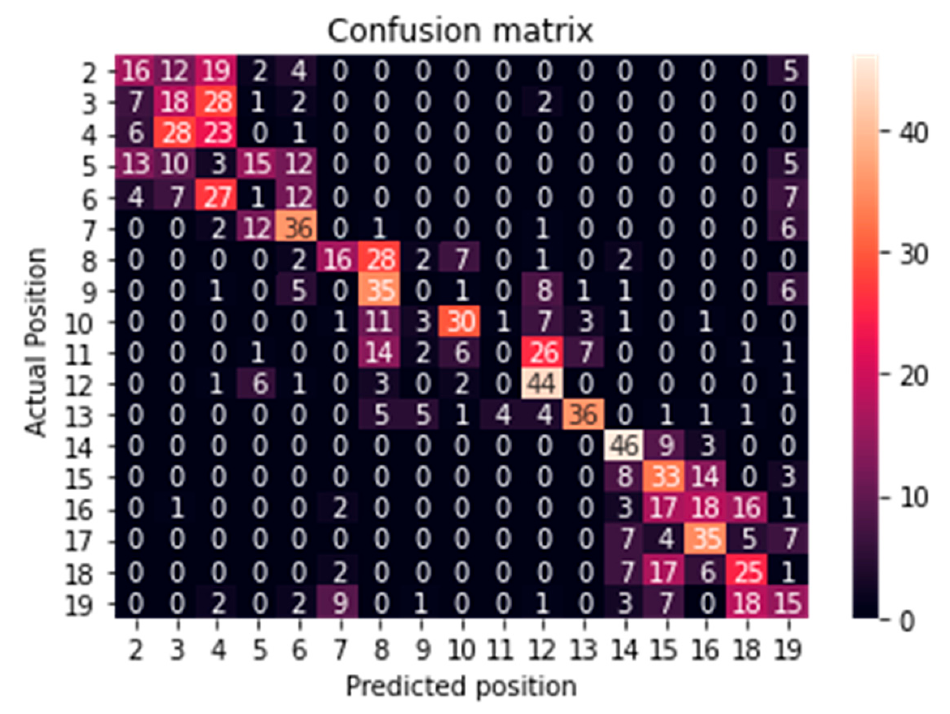
Figure 7. Confusion matrix for first measurement campaign based on test data set.